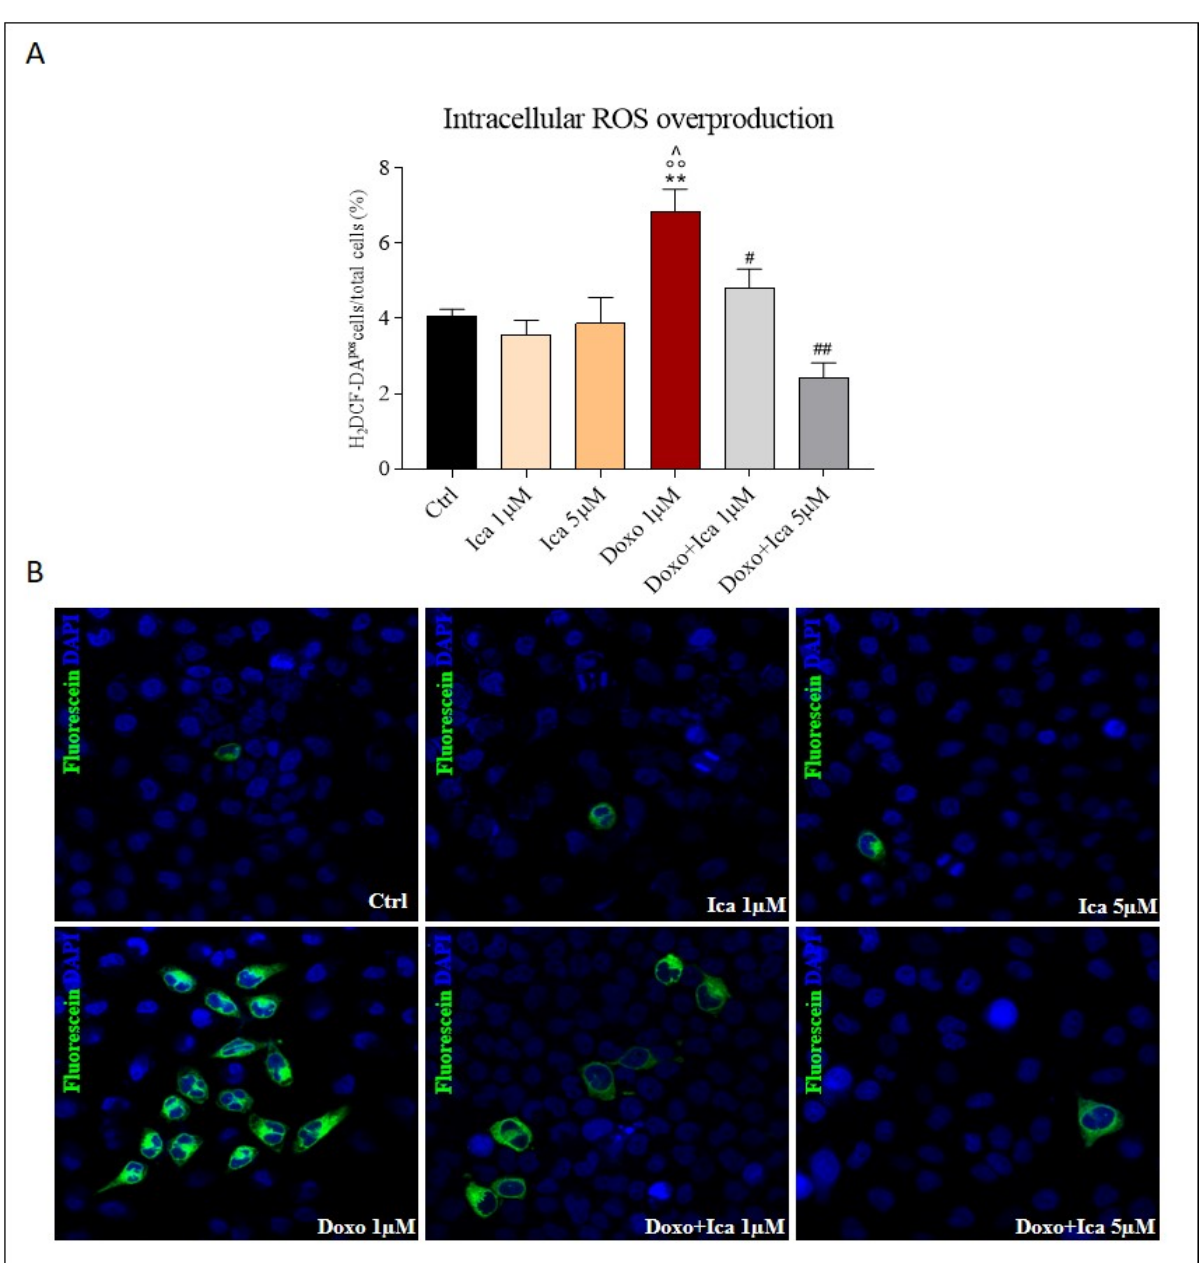
Figure 3. Ica reduces intracellular reactive oxygen species overproduction. ( A ) . Reactive oxygen species (ROS) overproduction was determined by immunofluorescence assay. Oxidative stress was quantified by counting ∼ 1000 myoblasts/slide, for a minimum of three slides per sample, and the ROS positive fraction was expressed as a percentage of total myoblasts. ( B ). Representative confocal images of H9c2 cells treated as described above. Green staining showed fluorescent probe 2’,7’—dichlorodihydrofluoresceindiacetate (DCFH-DA), blue staining showed DAPI (4’,6-diamidino-2-phenylindole), used for nucleic acid staining. Cell images were collected using a 40× confocal microscope objective. Data are expressed as mean ± SEM., ** p < 0,01 vs. Ctrl; °° p < 0,01 vs. Ica 1 μ M; ^ p < 0,05 vs. Ica 5 μ M; # p < 0,05 vs. Doxo; ## p < 0,01 vs. Doxo; Mann Whitney test ( n = 3). Data is for three independent experiments.